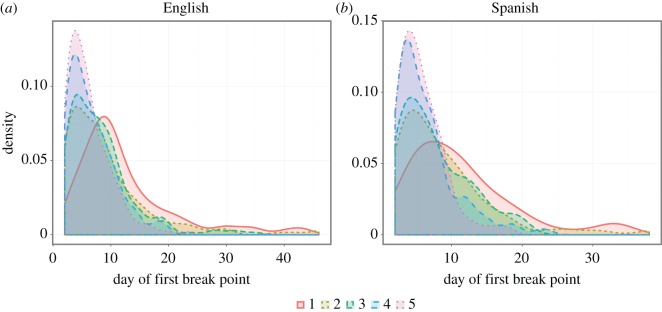
Distribution of the location of the first break point (days) for segmented regressions with different numbers of break points.